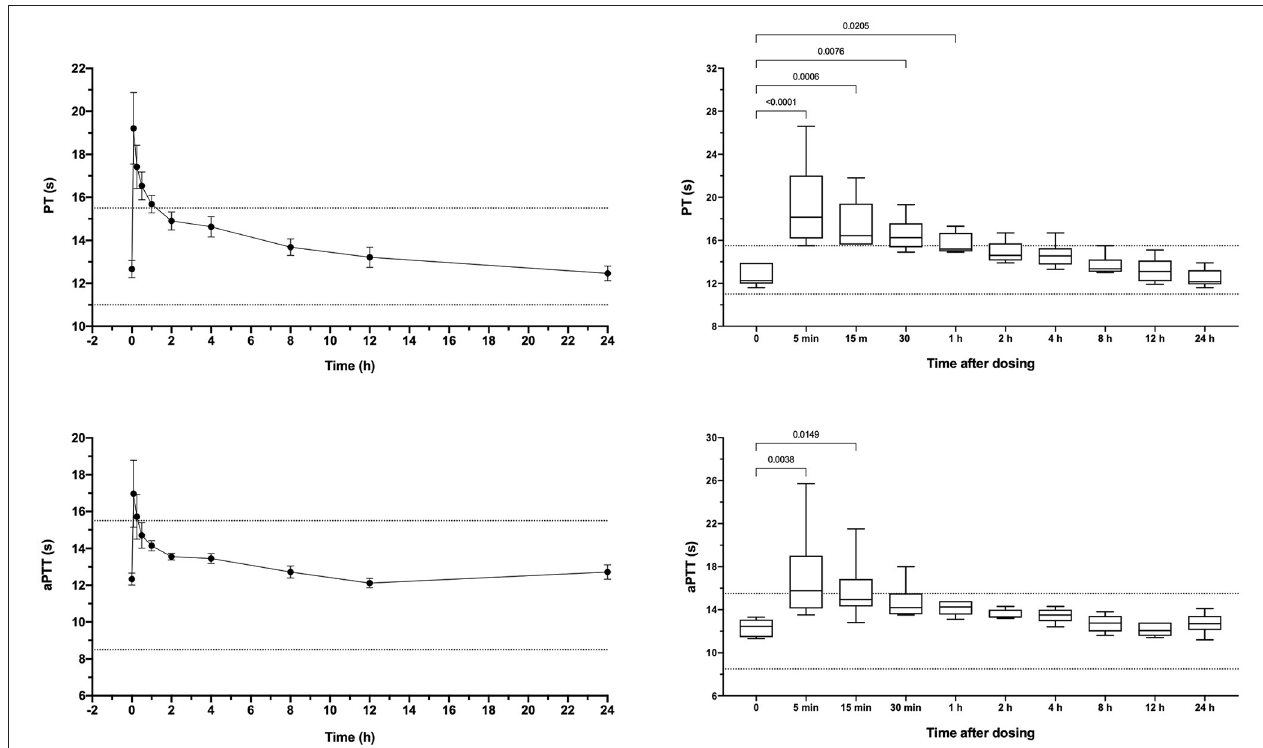
FIGURE 3 | Dotplots and box-whisker plots representing the prothrombin time (PT) and activated partial thromboplastin time (aPTT) values following intravenous administration of apixaban (0.2 mg/kg). Data presented on the left panels represent mean ± standard deviation values, while data on the right panels represent median (middle line), 25–75% percentile (box) and min-max (whiskers) for each time point. Dotted horizontal lines represent the upper and lower bounds of the laboratory reference interval. For the box-whisker plots, comparisons between baseline and subsequent time points were conducted using the Friedman test with Dunn’s post-hoc correction for multiple comparisons. Only those comparisons that attained P < 0.05 are